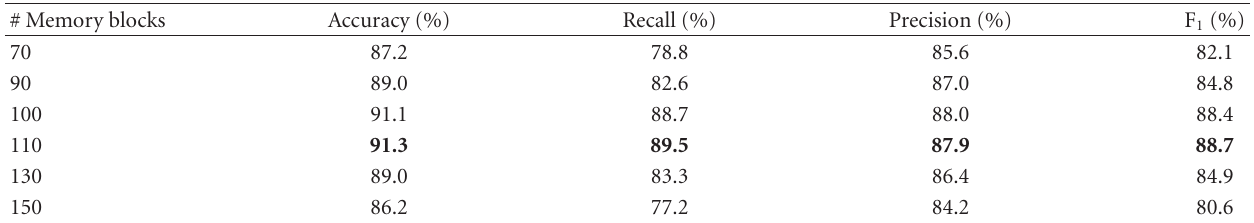
Table 4: Sample-wise classification of driver distraction (attentive vs. distracted) using LSTM networks: accuracy, unweighted recall, unweighted precision, and F1-measure for di ff erent numbers of memory blocks.